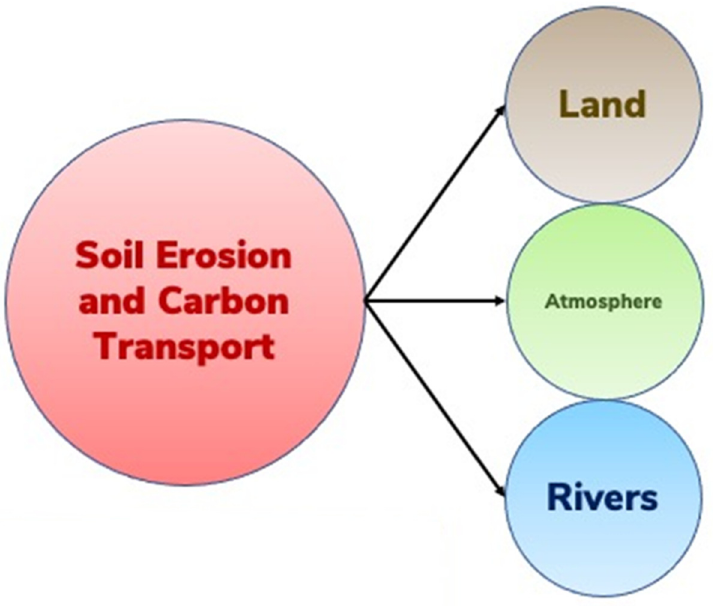
Figure 2. The soil erosion process impacting the exchange of Carbon (C) between the land, atmosphere, and rivers after the global C budget, which must be duly accounted for.